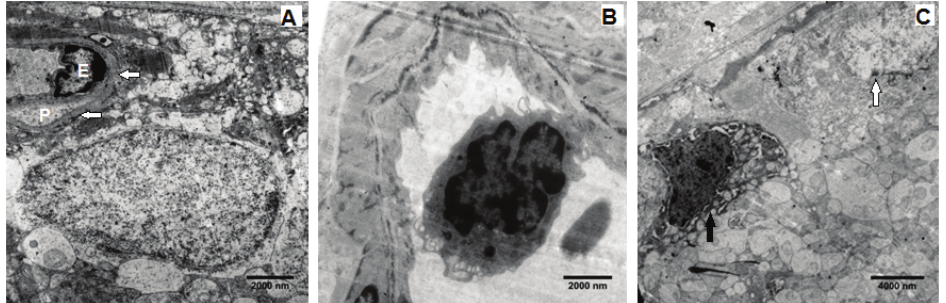
Figure 5. Electron micrographs of a retinal ganglion cell (RGC) in groups C and G (A), group D (B), and group DG (C). (A) An RGC with uniformly distributed chromatin throughout its nucleus. Note a typical normal retinal capillary composed of an endothelial cell (E) and pericyte (P) surrounded by the basement membrane (arrows). (B) An apoptotic RGC with shrunken nucleus containing condensed and marginated chromatin. (C) An RGC with relatively uniformly dispersed chromatin (black arrow) and a normal RGC (white